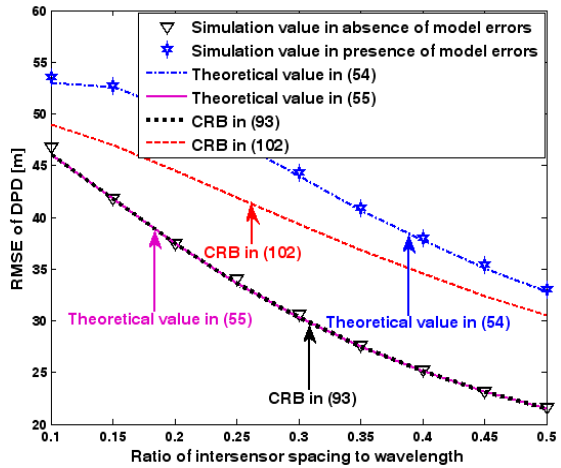
Figure 5. RMSE of DPD versus ratio of intersensor spacing to wavelength.